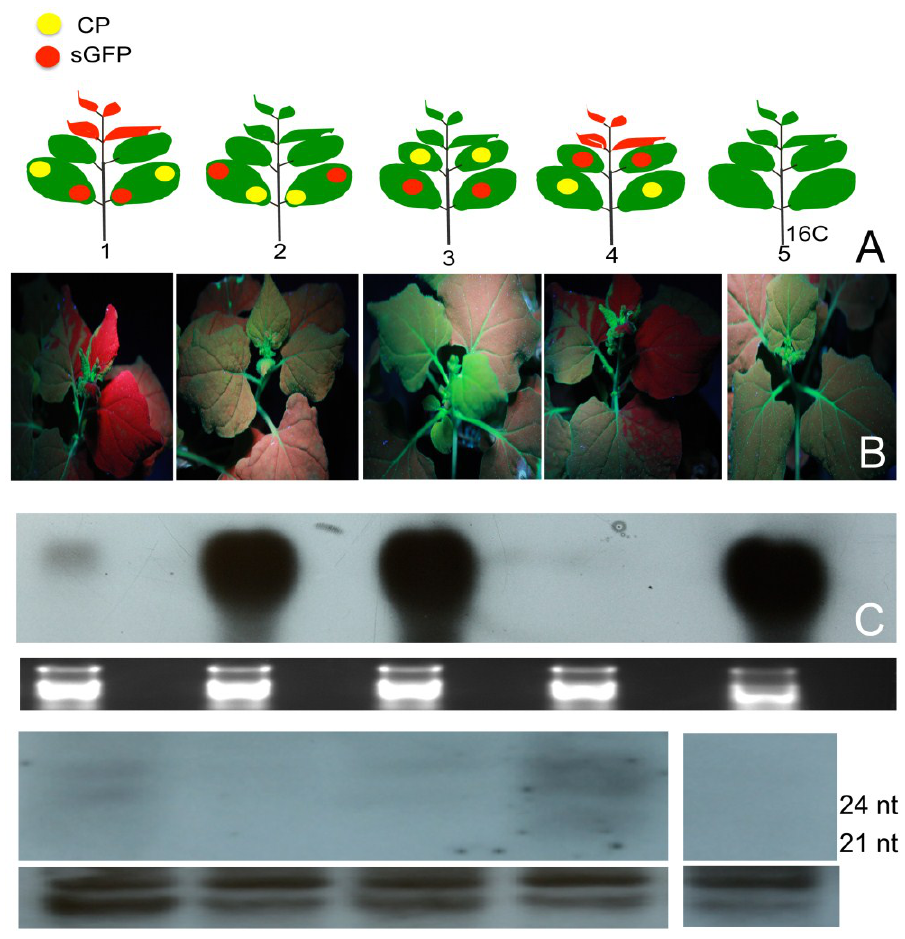
Figure 6. Molecular analysis of PMWaV-2 CP for its ability to interfere with the systemic RNA silencing signal. ( A ) Schematic showing simultaneous infiltration of 35S-sGFP (red circles) and PMWaV-2 CP constructs (yellow circles) in two different parts of the same leaf (proximal or distal; treatments 1 or 2) or into different leaves (lower leaf or upper leaf; treat- ments 3 or 4) of transgenic N. benthamiana 16C plants. Plant 5 is non-infiltrated plant. ( B ) Photographs of upper leaves showing the effect of the infiltrations described in panel ( A ). ( C ) Northern blot analysis of GFP mRNAs (upper) and siRNAs (lower) from non-infiltrated systemic leaves on infiltrated plants as depicted in panels ( A ) and ( B ). Loading of RNAs on GFP northerns was estimated by ethidium bromide staining of ribosomal RNA. Loading of RNAs for GFP siRNA analysis was estimated by comparison to tRNAs on the same